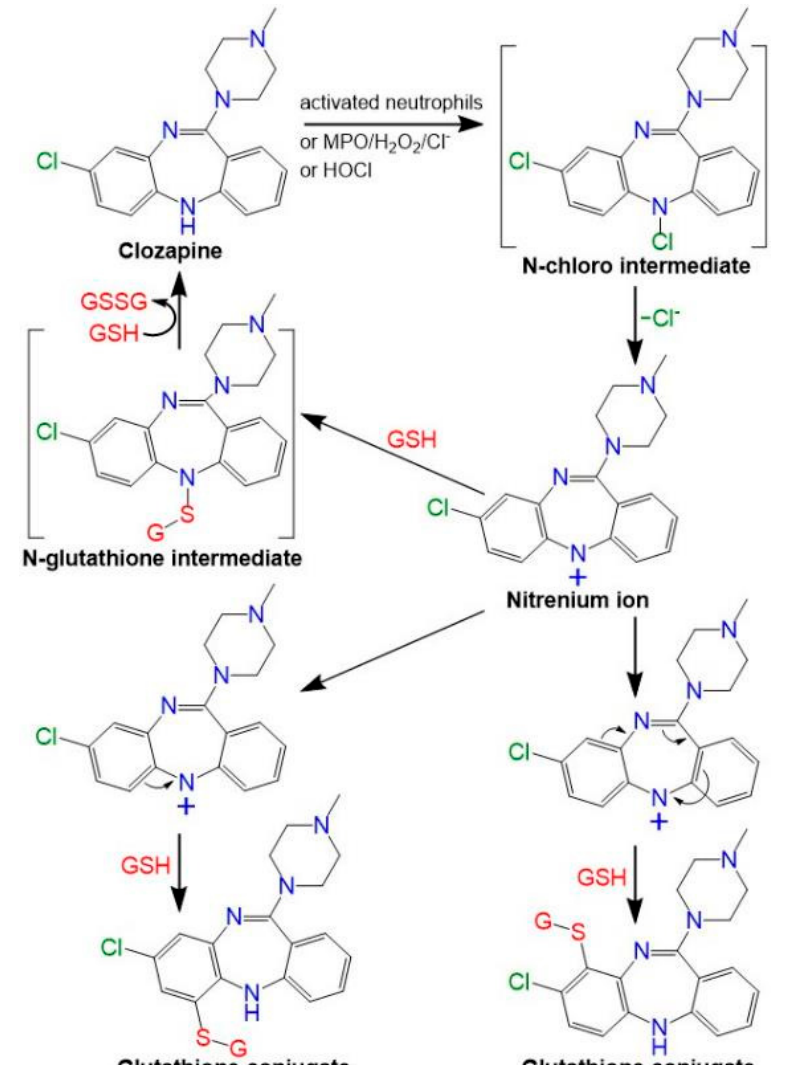
Figure 1. Myeloperoxidase-mediated bioactivation of clozapine [34]. Clozapine can be oxidized by activated neutrophils, oxidant systems containing myeloperoxidase (MPO), hydrogen peroxide (H 2 O 2 ), and chloride, or hypochlorous acid to a reactive nitrenium ion that can be trapped by glutathione, resulting in the formation of two major glutathione conjugates [30,31,33]. Glutathione is also likely to react with one or more of the nitrogens; however, these products would be unstable, quickly reacting with another molecule of glutathione to regenerate clozapine and form oxidized glutathione. Due to the delocalization of the positive charge throughout the aromatic system, the nitrenium ion is stable for almost 1 minute in the buffer, much longer than the N-chloro precursor [30]. In the absence of glutathione, the reactive metabolite covalent binds to other peptides and proteins [20,22,27,32,33]. MPO, myeloperoxidase; H 2 O 2 , hydrogen peroxide; HOCl, hypochlorous acid; GSH, reduced glutathione; and GSSG, oxidized glutathione.